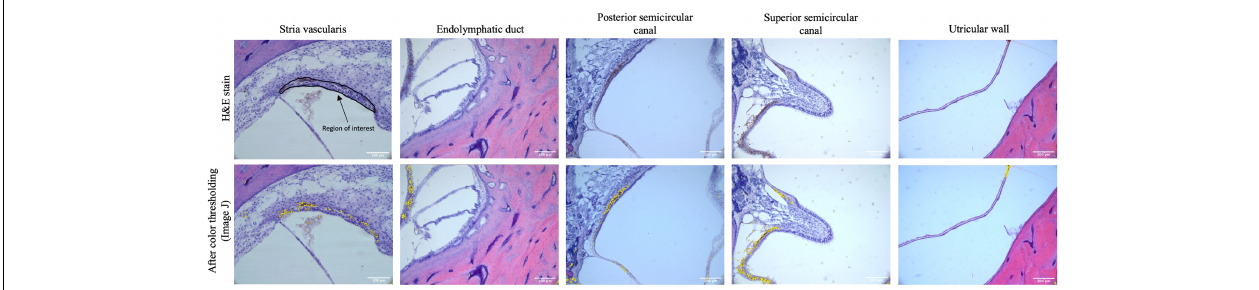
FIGURE 1 | The top row shows representative images of the stria vascularis, endolymphatic duct, posterior semicircular canal, superior semicircular canal, and utricular wall in human temporal bones taken at 10 × magnification using light microscopy. The stria vascularis is outlined (region of interest) in the top left panel. For the vestibular system the entire image as pictured above was used as the region of interest to measure pigment content. The bottom rows shows the images after color thresholding on ImageJ with the pigmented areas shaded in yellow.